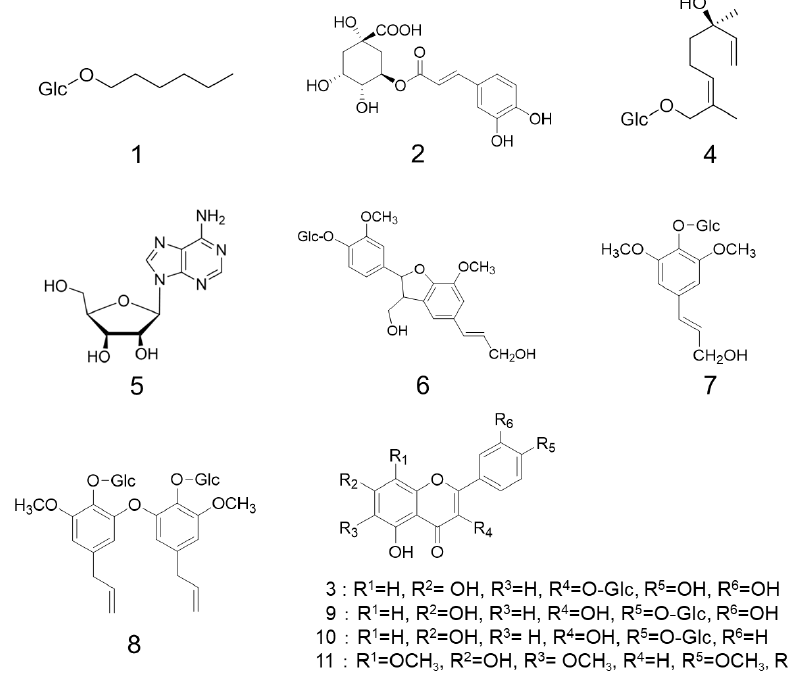
Figure 2. Isolated compounds.